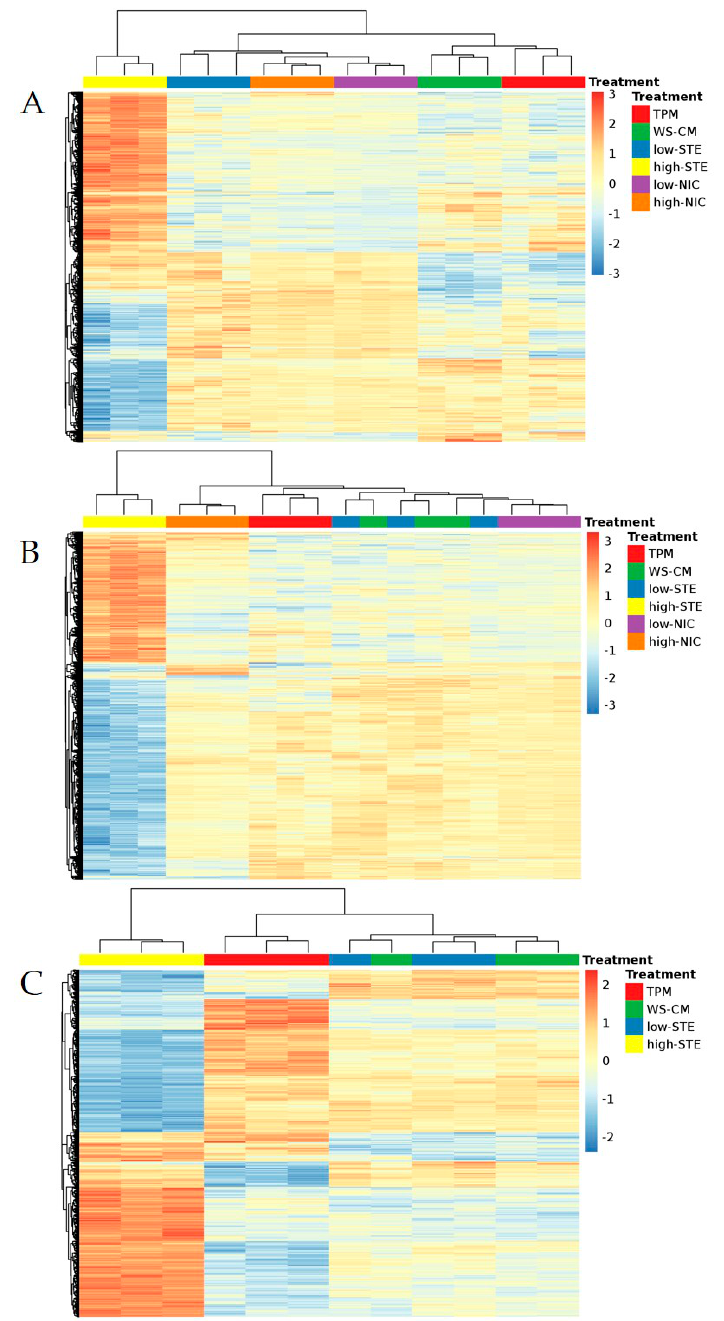
Figure 1. Heat maps of the differentially expressed probe sets in each cell line: ( A ) human gingival epithelial cell (HGEC) line; ( B ) non-metastatic 101A cell line; ( C ) metastatic 101B cell line. Hierarchical clustering was performed to cluster samples and probe sets into similar clusters. The color scale represents the log2 fold change ranging from − 3 (dark blue) to 3 (dark red). Different treatments were color coded as follow: red = total particulate matter (TPM), blue = low-smokeless tobacco extract (low-STE), green = whole-smoke conditioned media (WS-CM), purple = low-nicotine (low-NIC), orange = high-nicotine (high-NIC), and yellow = high-smokeless tobacco extract (high-STE).